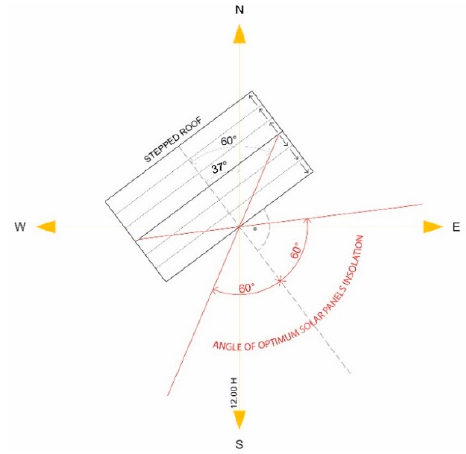
Figure 7. A house oriented at an angle of 37° from the N–S direction with PV panels installed on a stepped roof (diagram by W. Celadyn, P. Filipek).